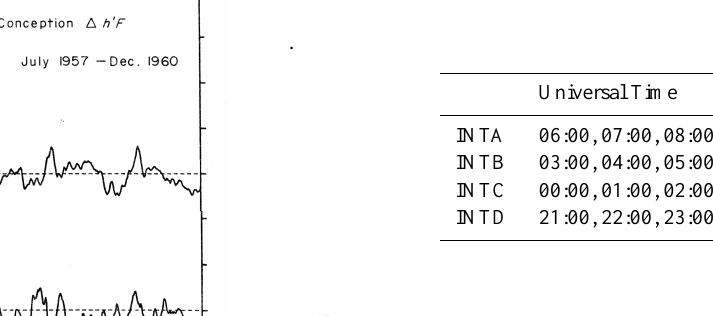
Table 2. Geomagnetic